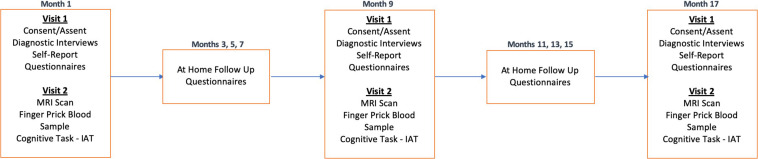
Longitudinal study protocol. TIGER is a longitudinal study approximately 18-months long with 3 timepoints, approximately 9 months apart. Each timepoint will include two laboratory visits (Visit 1 and Visit 2). Every other month between laboratory sessions we will also obtain self-report measures of depression (RADS-2, PHQ-9) and anxiety (MASC-2), as well as information on any potential treatment changes. Please also see Table 1 for a list of measures collected within each session visit at each timepoint.